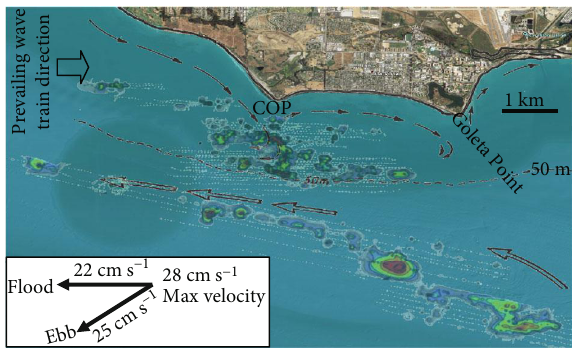
Figure 23: Generalized nearshore currents (not surface) for the COP seep fi eld area showing generalized o ff shore currents for the COP seep fi eld. COP seep fi eld sonar map for 2005 added for spatial reference (see Figure 18 for sonar legend). Currents based on Fischer